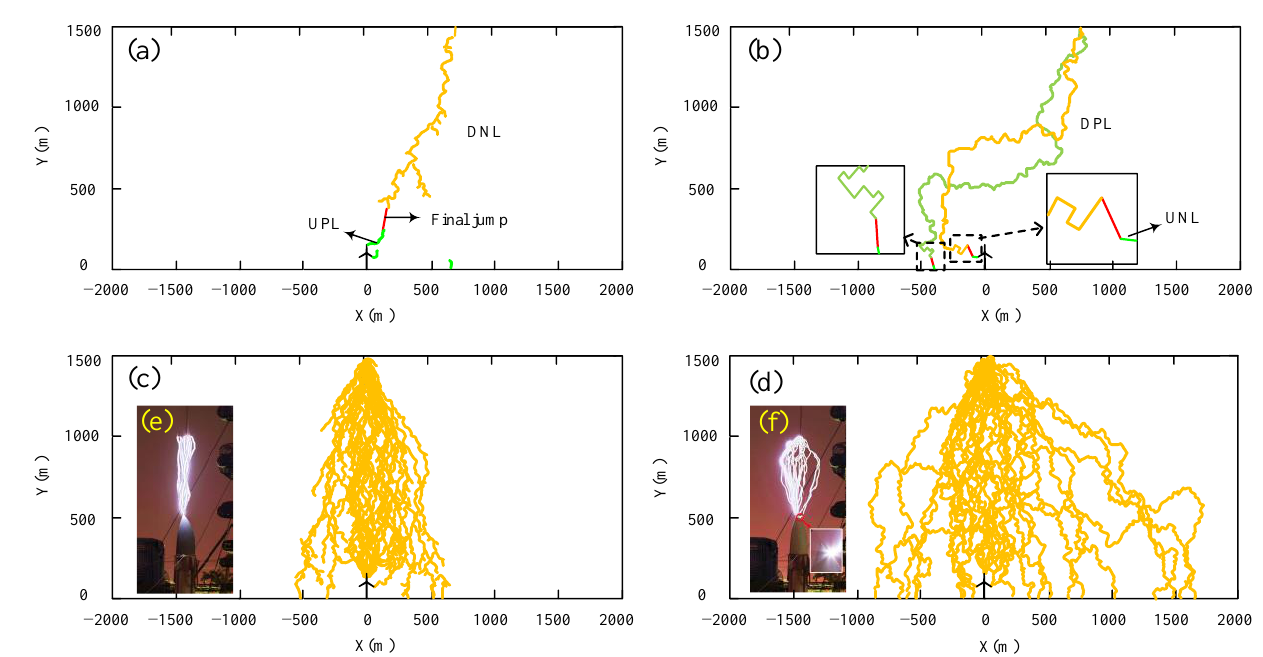
Figure 9. The development of lightning downward leaders: ( a ) A − CG flash strikes the No. 1 blade, ( b ) A +CG flash strikes the No. 3 blade (yellow line) and a +CG flash strikes the ground (green line), ( c ) 30 paths of the − CG flash ( d ) 30 paths of the +CG flash ( e ) Experimental result for paths of 20 negative discharges ( f ) Experimental result for paths of 20 positive discharge.